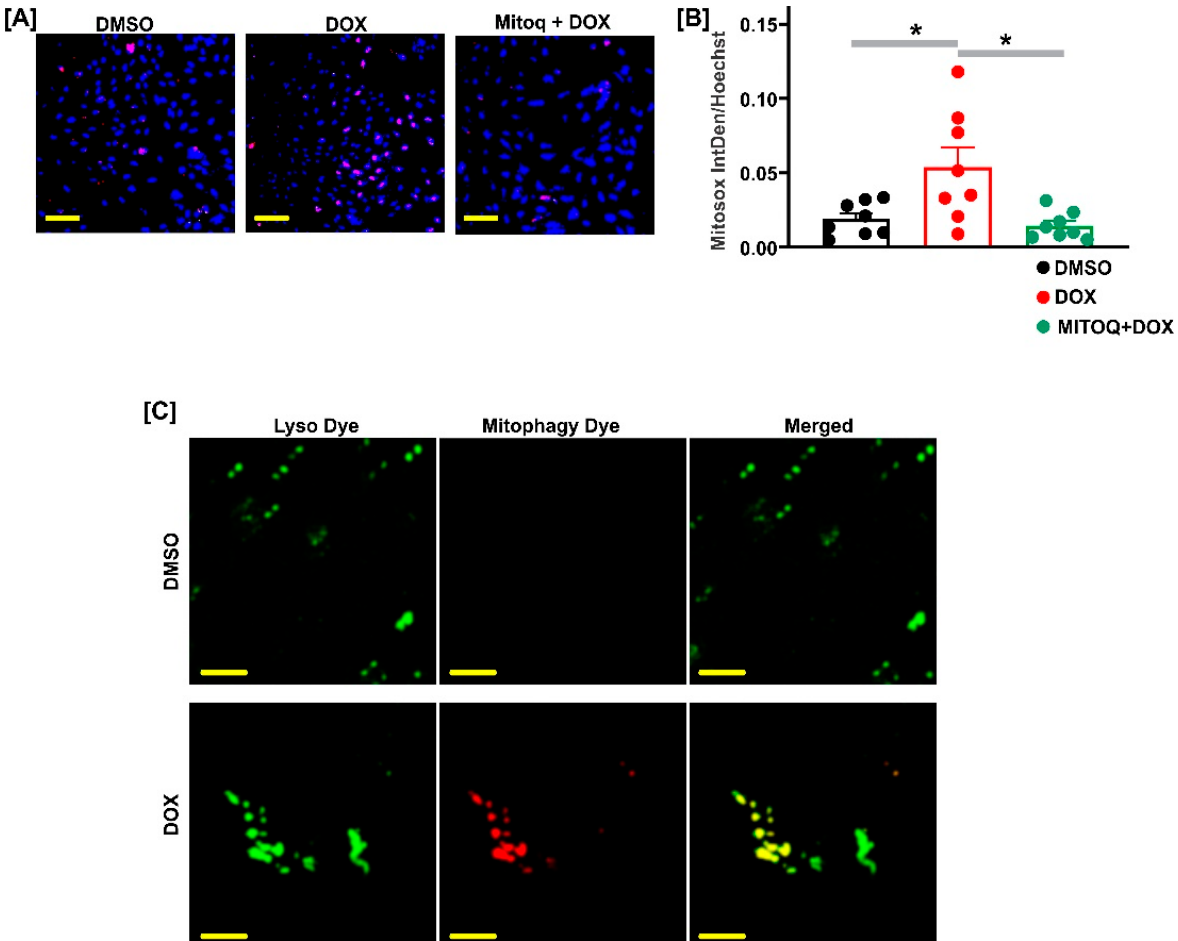
Figure 3. DOX stimulates mtROS generation in fetal GMCs. ( A , B ) Confocal microscopy images and charts showing increased MitoSOX Red staining (indicating ROS generation) in DOX (100 nM; 30 min)-treated cells and reversal by the mitochondria- targeted antioxidant mitoquinone (MitoQ 1 µ M). ( C ) Representative confocal microscopy images ( n = 4) showing induction of the mitophagy dye staining in DOX-treated cells. The mitophagy dye exhibits a weak basal fluorescence, but the fluorescence is induced when injured mitochondria fuse to the lysosome. The Lyso dye detects lysosomes in the cells. * p < 0.05 vs. DMSO/DOX (one-way ANOVA, with Tukey post hoc test). Scale bar = 100 µ M. Figure 1 indicates significant cell death in the DOX-treated cells. To examine whether DOX induces fetal pig GMC apoptosis, we measured caspase-3/7 activity in the cells. As shown in Figure 4A,B, DOX engendered an increase in caspase-3/7 activity in a concentration- and time-dependent manner. Pretreatment of the cells with MitoQ and Ac-DEVD-CHO (a caspase-3 and caspase-7 inhibitor) reversed DOX-induced caspase-3/7 activation, indicating that mtROS mediates DOX-induced apoptosis in fetal pig GMCs (Figure